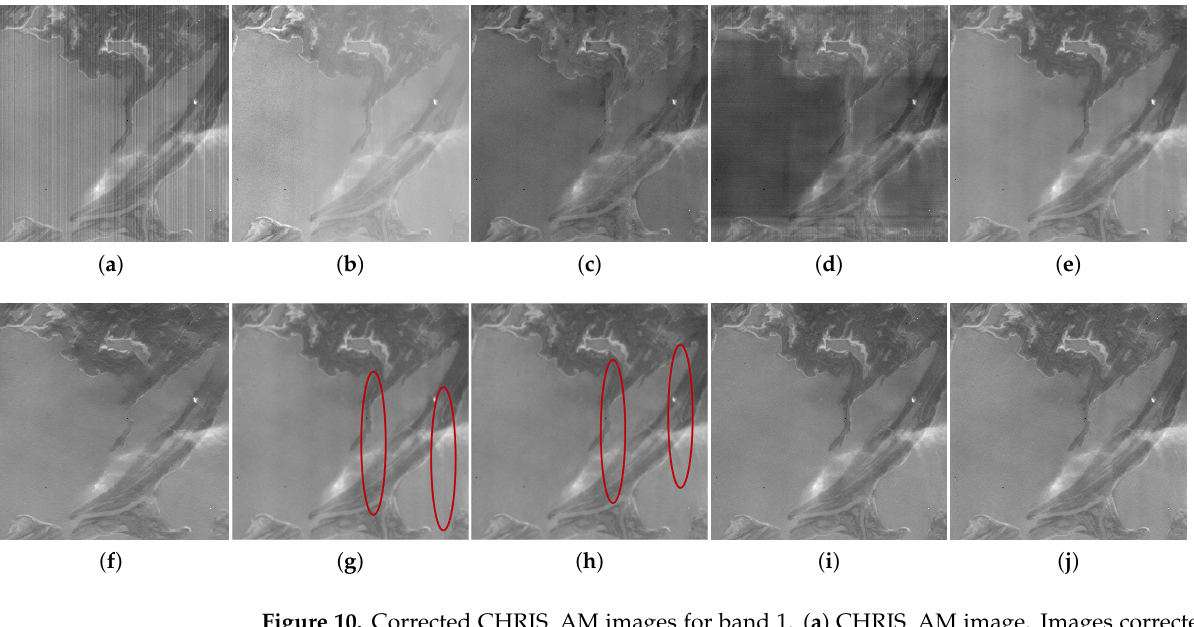
Figure 10. Corrected CHRIS_AM images for band 1. ( a ) CHRIS_AM image. Images corrected